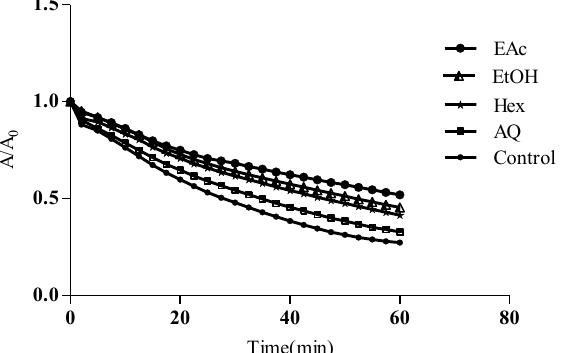
Figure 4. Kinetic profiles of pyrogallol consumption in the presence and absence of M. arboreus extracts/its fractions. Pyrogallol (30 μM) was incubated in presence of AAPH (600 mM) and different amounts of M. arboreus products as described in Materials and